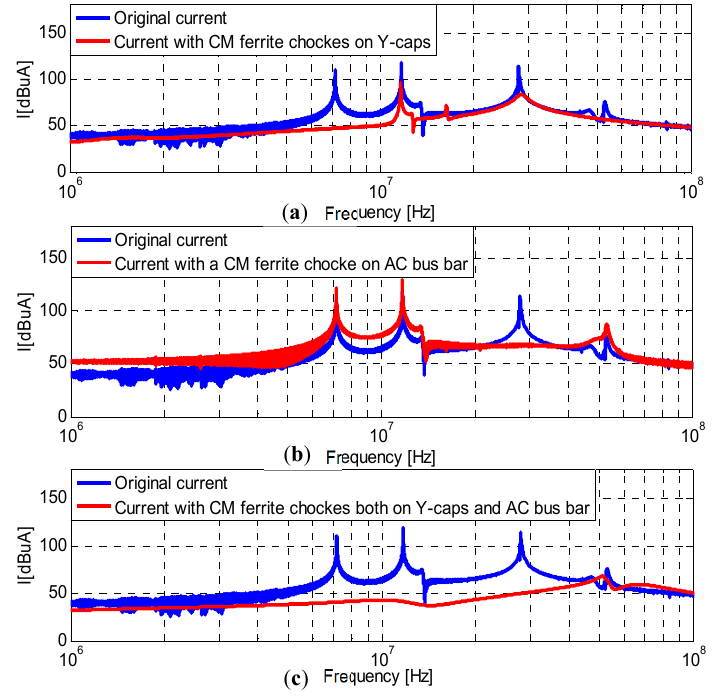
Figure 21. Change in CM current flowing one AC cable from mitigation. ( a ) CM ferrit chockes on Y ‐ caps ( b ) CM ferrit chockes on AC bus bar ( c ) CM ferrit chockes both on Y ‐ caps and AC bus bar.